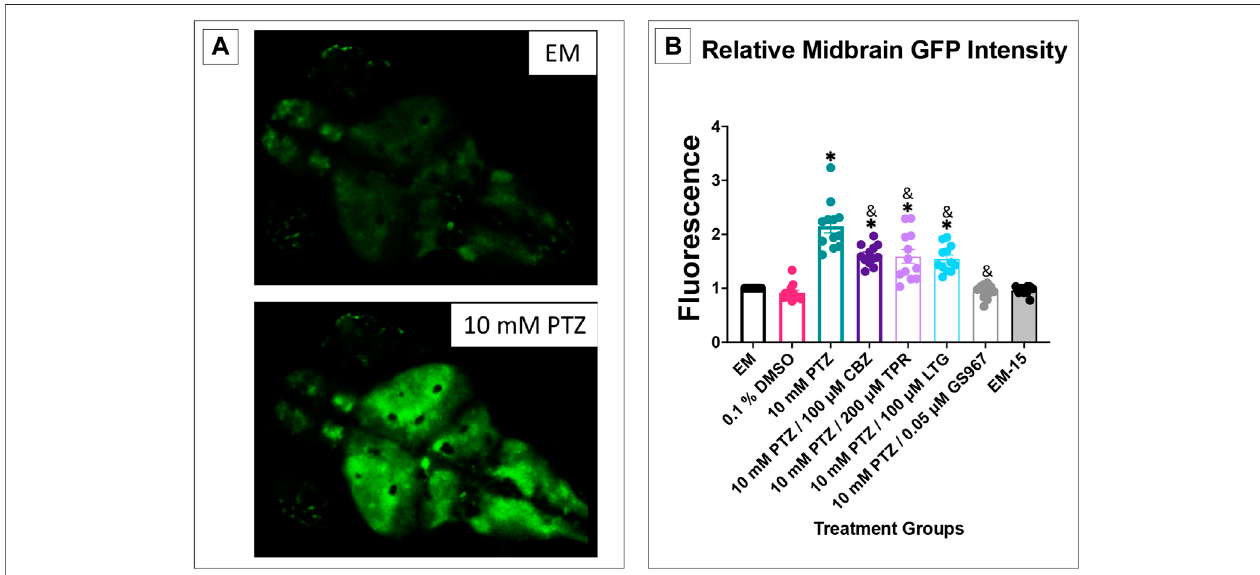
FIGURE 6 | Calcium signaling activity in 7 dpf larvae. The fl uorescence score is displayed on the y -axis. The respective treatment groups are shown on the x -axis. Analyses(one-way ANOVA, Tukey ’ spost-hoc) aremarked *( p < 0.05) toindicate signi fi cantdifferences to embryo medium (EM). Standard error ofthemeans isshown. Analyses (one-way ANOVA, Tukey ’ s post-hoc) are marked & ( p < 0.05) to indicate signi fi cant differences to 10 mM PTZ. ( n = 12 fi sh/treatment